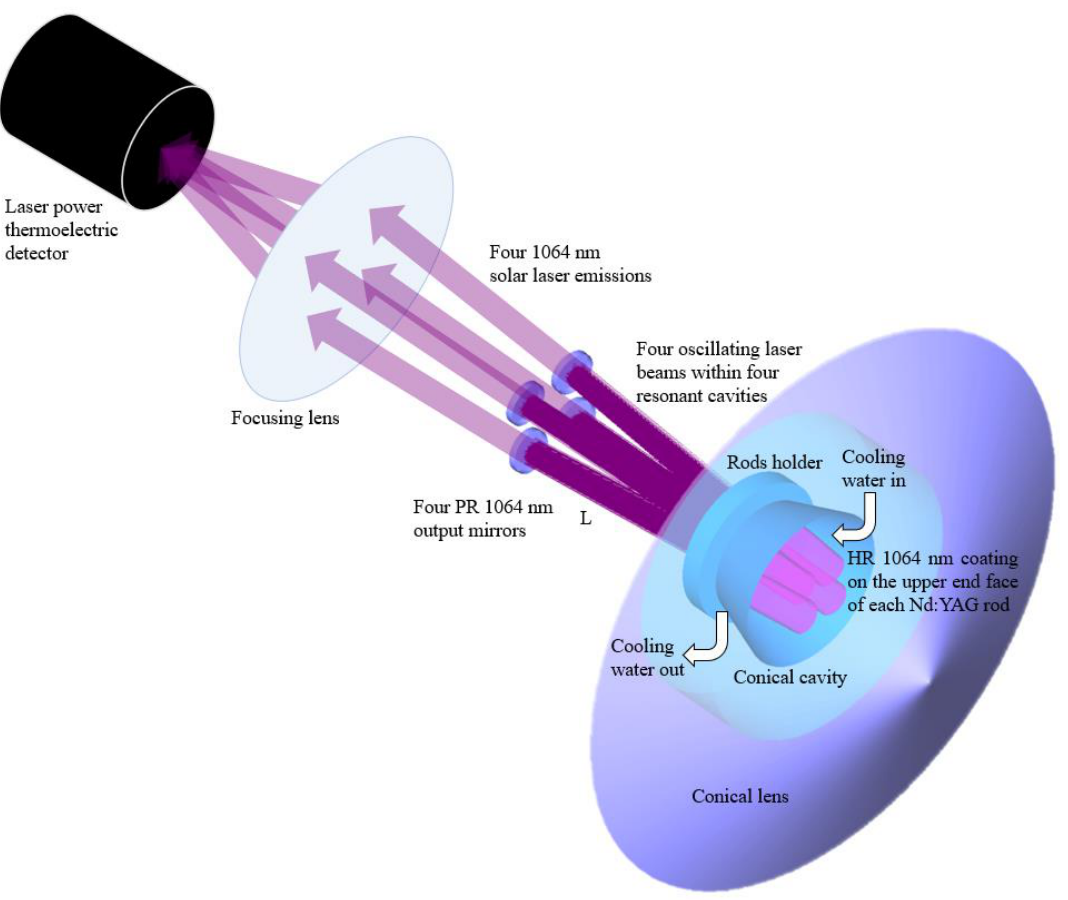
Figure 4. Solar-power-to-four-laser-beam conversion approach. Four PR 1064 nm laser output couplers were positioned near of their respective four Nd:YAG rods for the efficient extraction of four output laser beams.